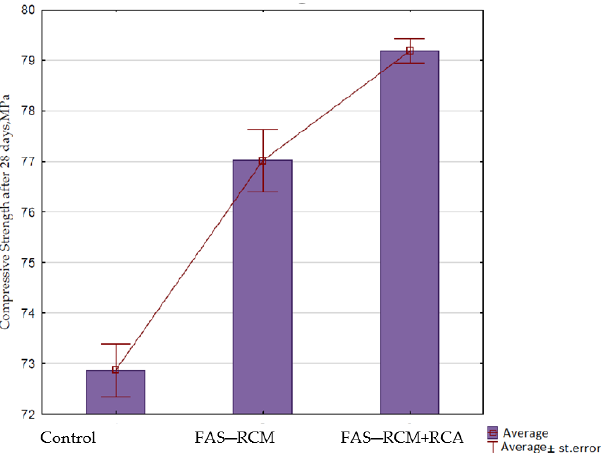
Figure 10. Average results of the compressive strength test of concrete after 28 days of maturation, MPa.